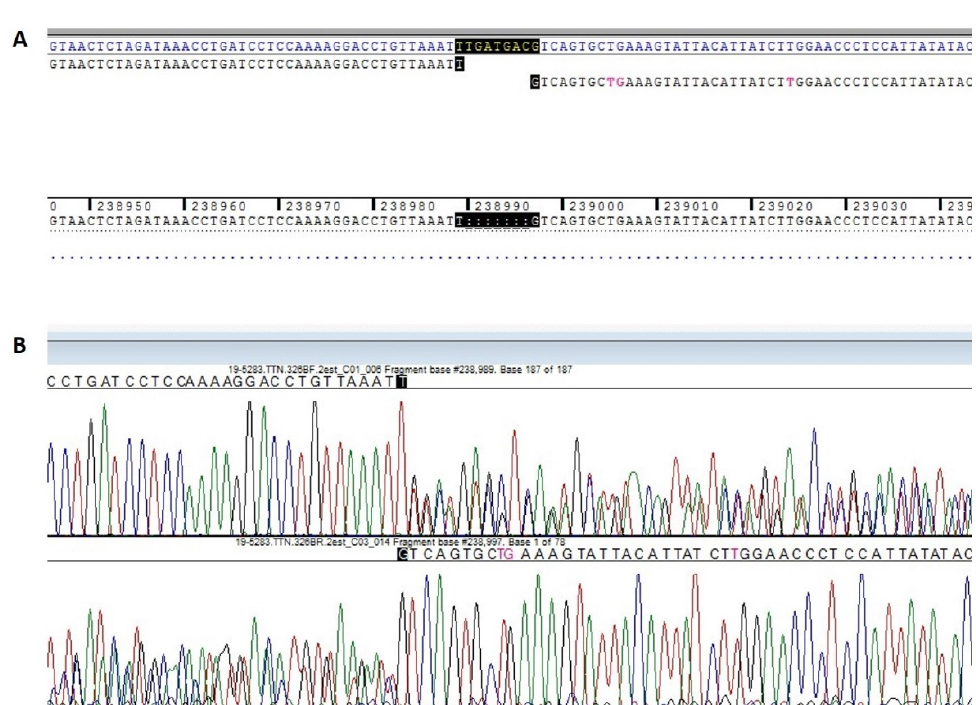
Figure 3. Post-next-generation sequencing (NGS) Sanger confirmation of the heterozygous TTN variant NM_001256850.1: c.72777_72783del. ( A ) Deletion of seven nucleotides in the DNA fragment of the TTN gene. ( B ) Demonstration of frameshift in the proband’s DNA fragments in the TTN gene mutated region.